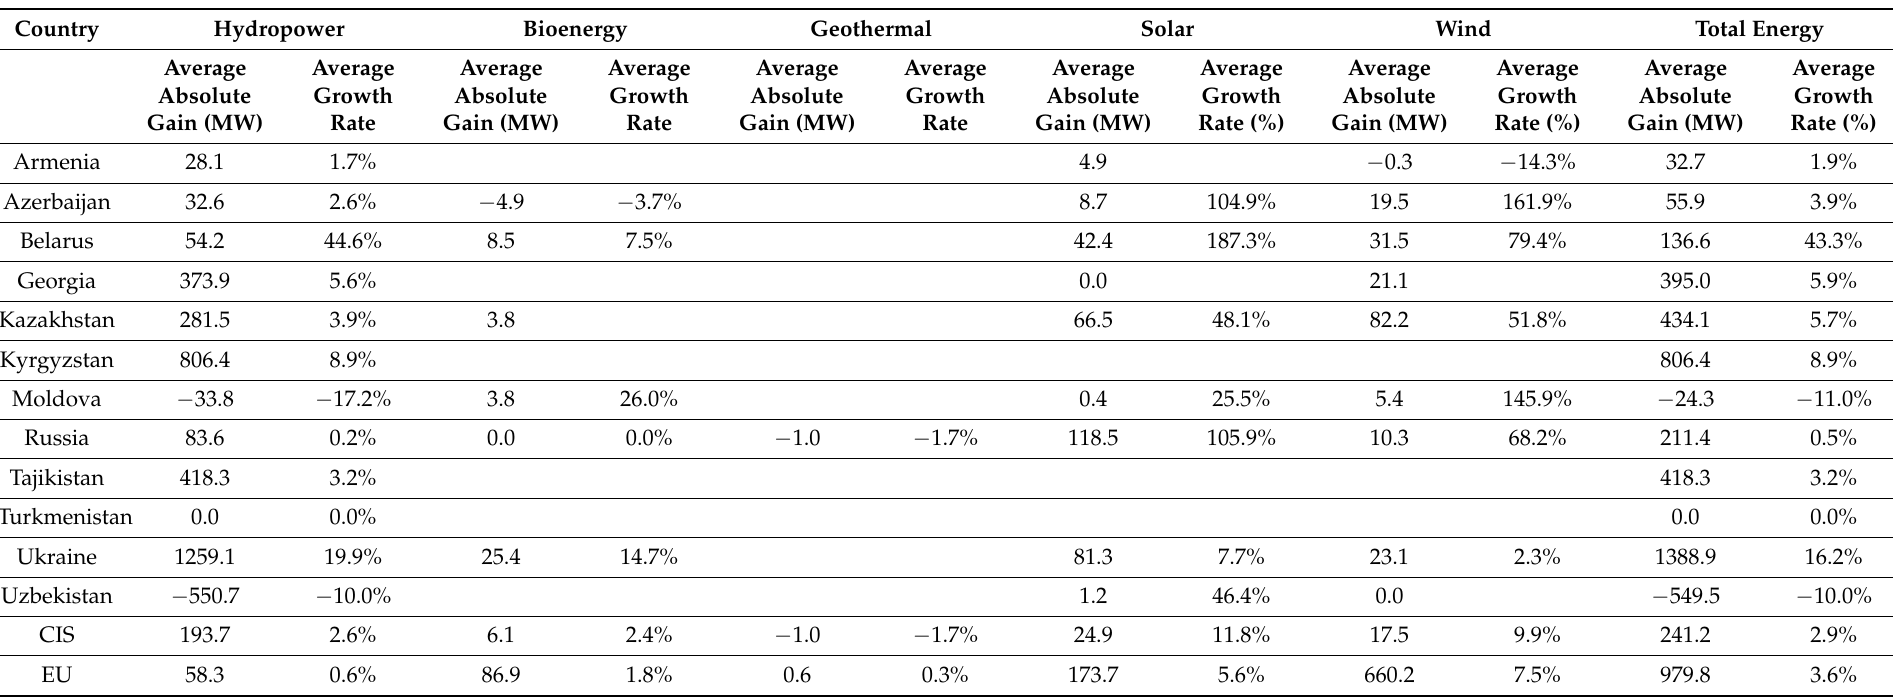
Table 3. The dynamics of renewable energy production in the CIS countries in